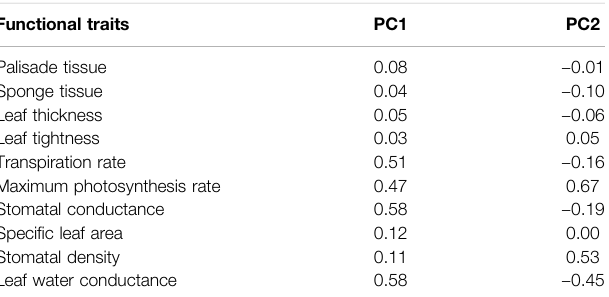
TABLE 2 | The fi rst two axes of a principal component analysis (PCA) for the eight fast-growingtreespeciesandeightdominantold-growthtreespecies,basedon 10planttraits. Theseincludepalisadetissue( μ m),spongytissue( μ m),leafthickness ( μ m), leaf tightness (%), stomatal conductance (mmol m -2 s -1 ), stomatal density (numbers mm -2 ), speci fi c leaf area (g cm -2 ), leaf hydraulic conductivity (k leaf ; mmol m -2 s -1 MPa -1 ), maximum photosynthesis rate (A mass ; μ mol m -2 s -1 ) and transpiration rate ( μ mol m -2 s -1